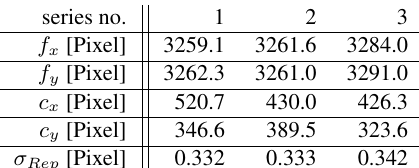
Table 2: Optical path calibration results for f L = 35 mm. The optical path calibration was performed three times for the 35 mm focal length. For each calibration series a chessboard pattern was recorded from 50 different